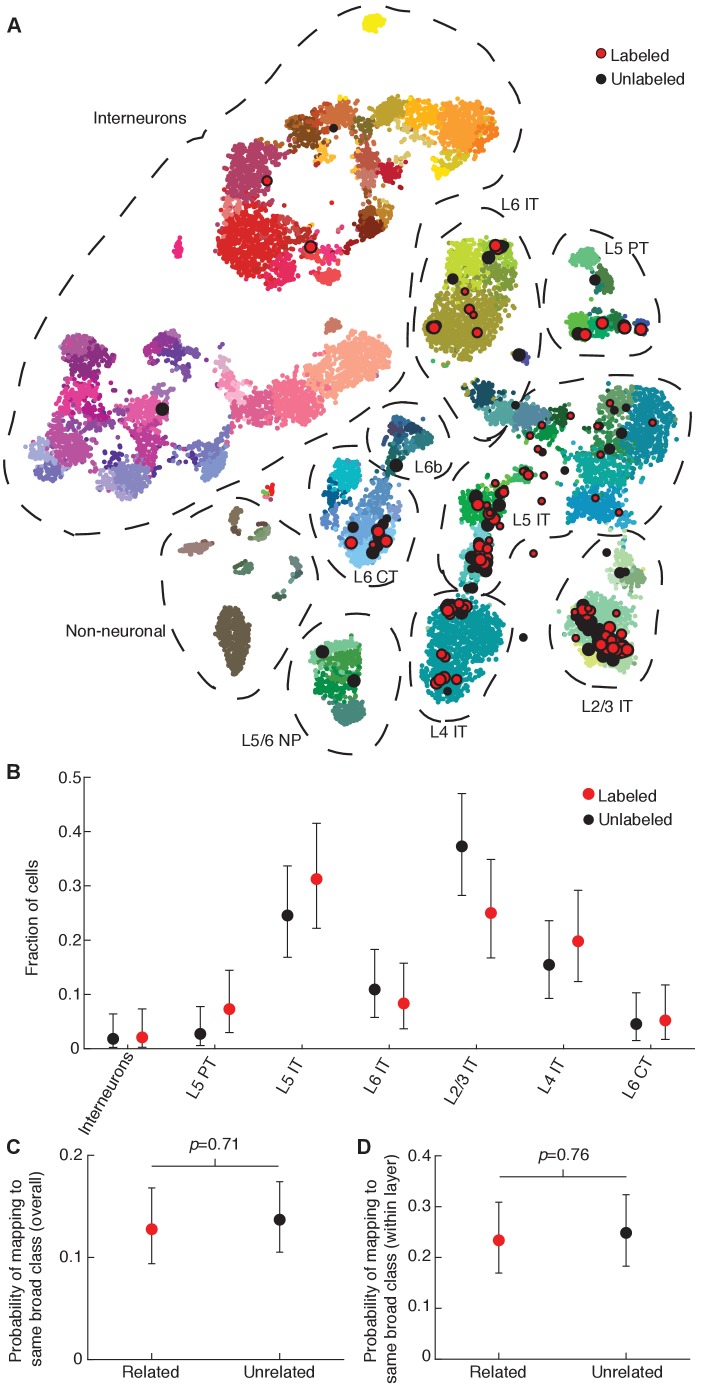
Translaminar clones labeled at E10.5 are composed of diverse classes of excitatory neurons, related to Figure 3.(A) T-distributed stochastic neighbor embedding (t-SNE) plot similar to 3A, but with Patch-seq data points (black outline, n = 96 and 110 labeled and unlabeled cells respectively) colored according to tdTomato expression status rather than cortical layer, aligned with a recently published mouse cell type atlas (data points with no outline; n = 23,822; from Tasic et al., 2018; colors denote transcriptomic types and are taken from the original publication). The t-SNE of the reference dataset and the positioning of Patch-seq cells were performed as described in Kobak and Berens (2019), see Materials and methods. The size of the Patch-seq data points denotes the precision of the mapping (see Methods): small points indicate high uncertainty. (B–D) A similar analysis to 3B–D, but using broad cell classes (outlined in panel A) rather than specific transcriptomic cell types. (B) Fraction of labeled (n = 96) and unlabeled (n = 110) cells that mapped to each of the broad classes with greater than three Patch-seq cells total (p=0.38, Chi-squared test). (C and D) Probability of related and unrelated cell pairs mapping to the same broad class either overall (C; n = 337 related pairs, n = 409 unrelated pairs; p=0.71, Chi-squared test) or conditioned on layer position (D; n = 154 related pairs, n = 157 unrelated pairs; p=0.76, Chi-squared test).